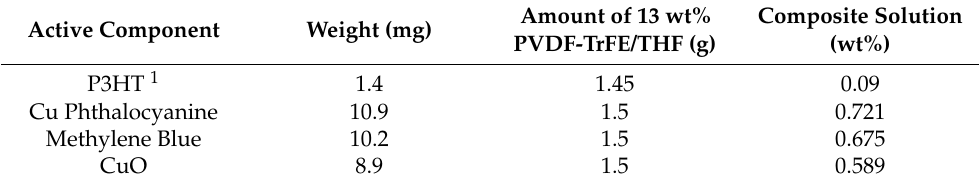
Table 1. Specifications of composite